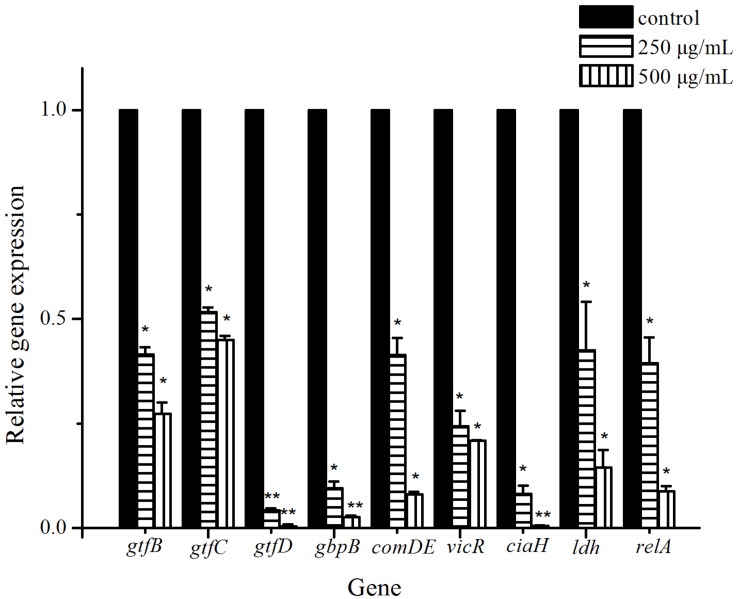
Effect of cinnamaldehyde on gene expression of S. mutans biofilms. The results represent the means and SD of three independent experiments performed in triplicate. ∗P < 0.05, ∗∗P < 0.01, significantly different from the control group.